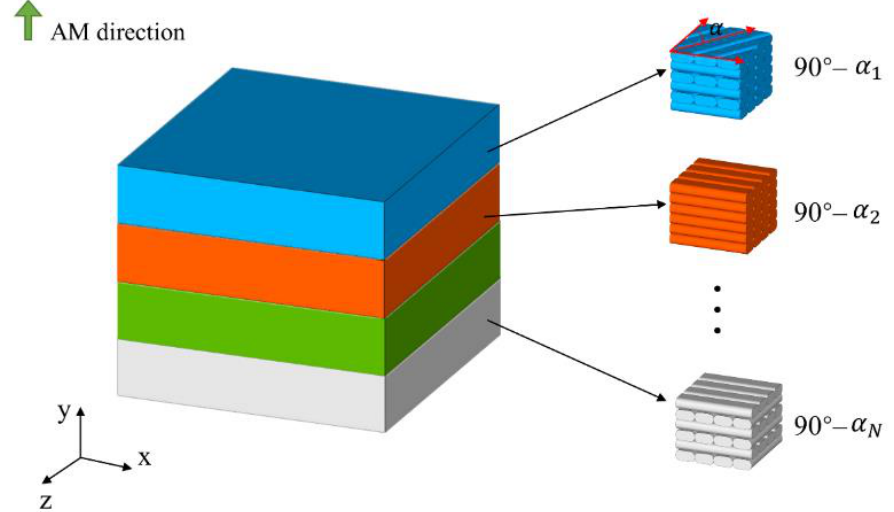
Figure 9. A 3D structure is divided into N regions with different cross-infill angles.